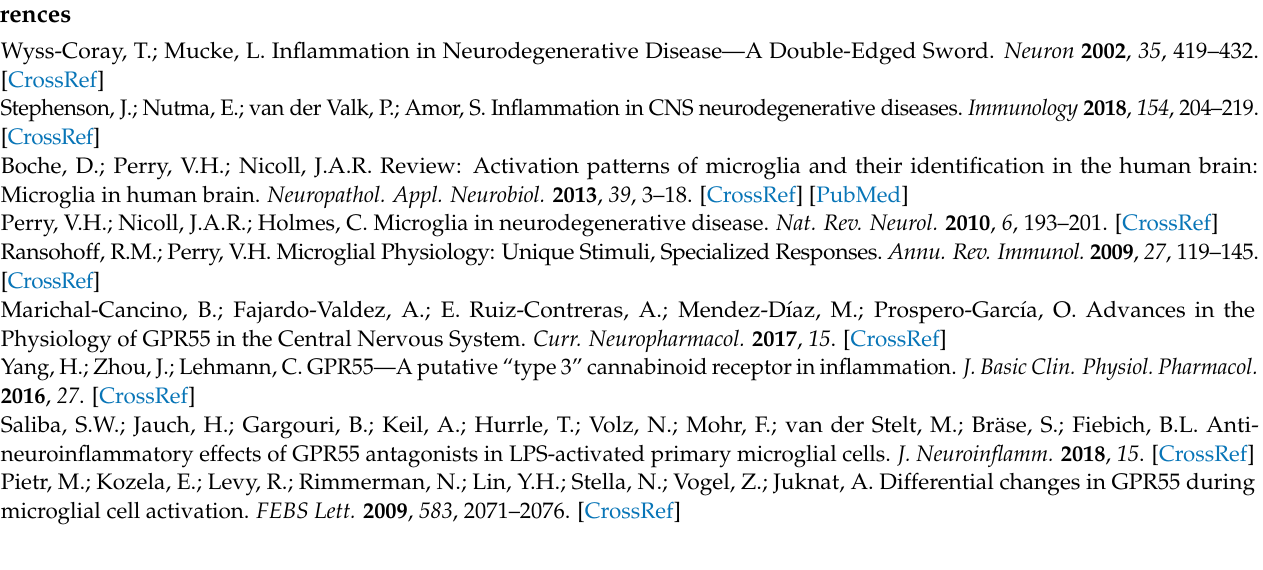
Figure A1. Showing original blots of studied protein targets: COX-2 ( A ), mPGES-1 ( B ) and respective Actin ( C ); phosphor-I κ B ( D ) and respective Actin ( E ); Phospho-JNK ( F ) and Total-JNK ( G ); Phospho- ERK 1/2 ( H ) and Total—ERK 1/2 ( I ); Phospho-p38 MAPK ( J ) and Total-p38 MAPK ( K ). After the successful transfer of protein on PVDF membranes, membranes were blocked and incubated with the respective as described in the method section of the main